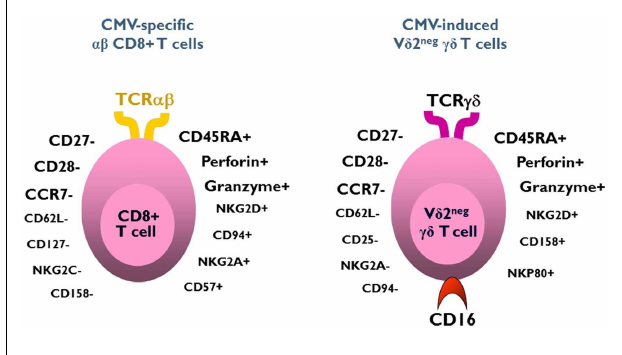
FIGURE 1 | Phenotype of CMV-inducedV δ 2 neg γδ T cells and CMV-specific CD8 + αβ T cells . Both subsets exhibit a similar effector/memoryTEMRA